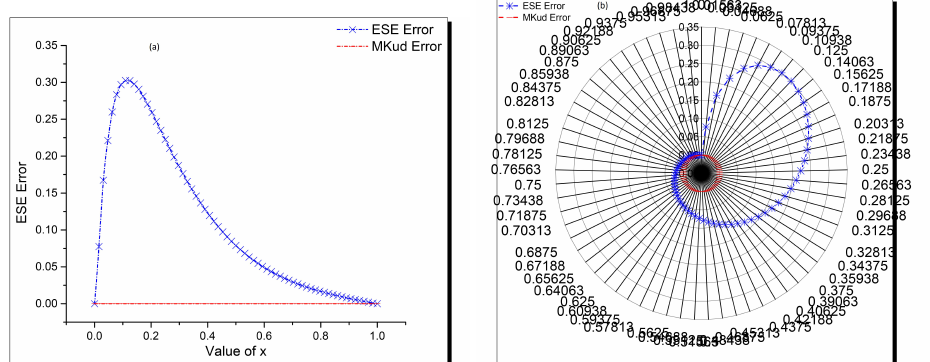
Figure 7. Two-dimensional ( a ) and radar ( b ) plots for the calculated absolute error along the MDA, MKud. analytical schemes and the TQBS numerical